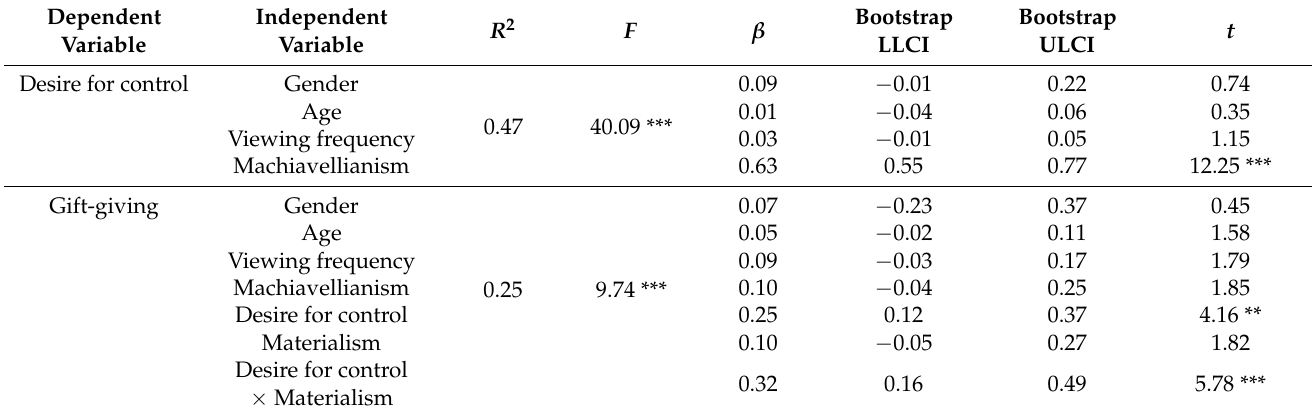
Table 2. The regression analysis of the moderated mediating model.